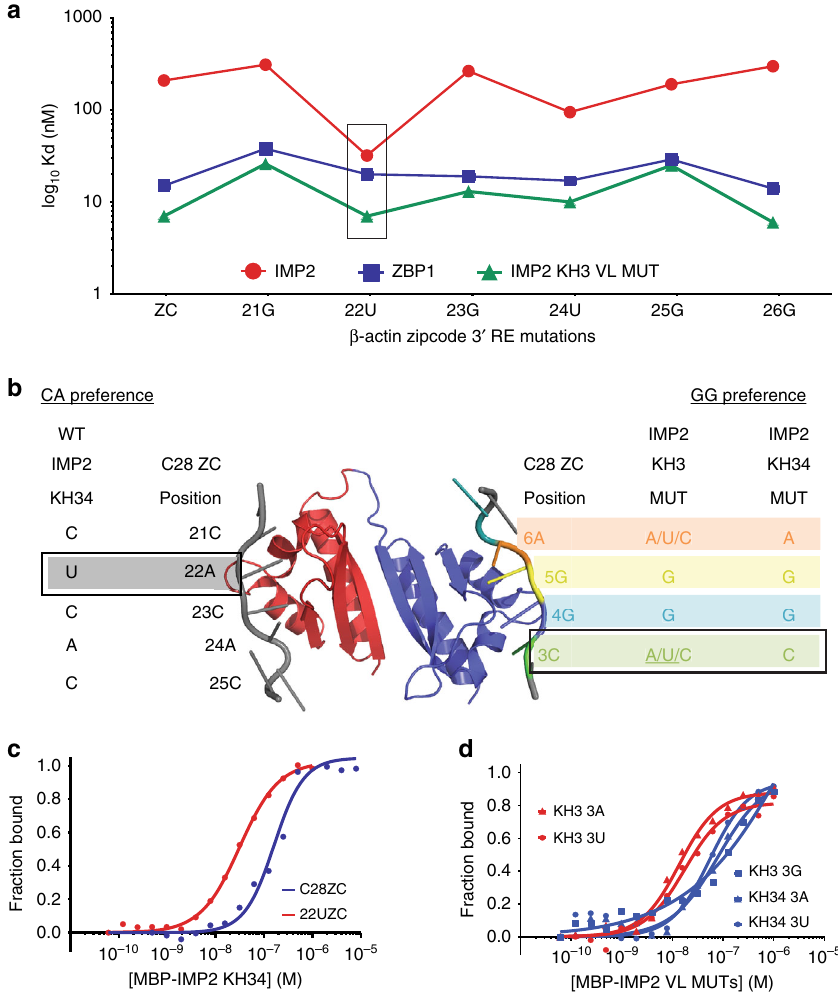
Fig. 5 Mutations validate the sequence preference of individual IMP2 RNA recognition elements. a K d measurements of IMP2KH34 WT, ZBP1KH34 WT (from Patel et al. 16 ) and IMP2KH3 variable loop mutant. Point mutations were made to the ß-actin actin zipcode sequence ( x -axis) and K d was measured by EMSA (gels in Supplementary Fig. 5). b Summary of sequence preferences for WT and variable loop mutants. Single-nucleotide mutants of the ß-actin zipcode consensus elements were tested against IMP2 variable loop mutants and the preferred nucleotide at each position in written (gels in Supplementary Fig. 5). Data for ZBP1 consensus sequence preference was obtained from Patel et al. 16 . c Quanti fi cation of representative EMSAs corresponding to B (gray box, gels in Supplementary Fig. 5). d Quanti fi cation of representative EMSAs corresponding to B (green box, gels in Supplementary Fig. 5) showing differences between mutant zipcode sequences that bind (red) and those that do not bind